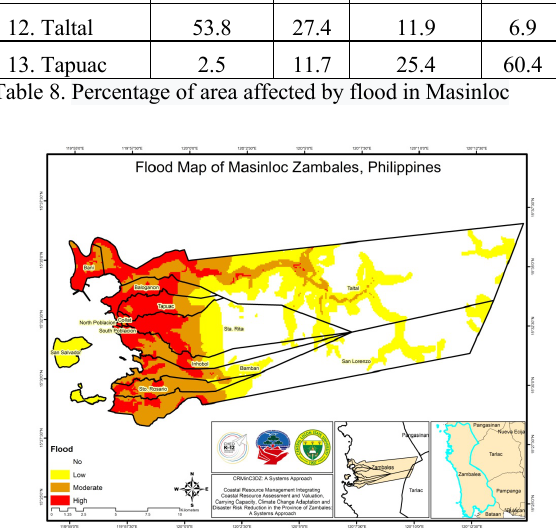
Figure 11. Flood hazard susceptibility of Masinloc, Zambales